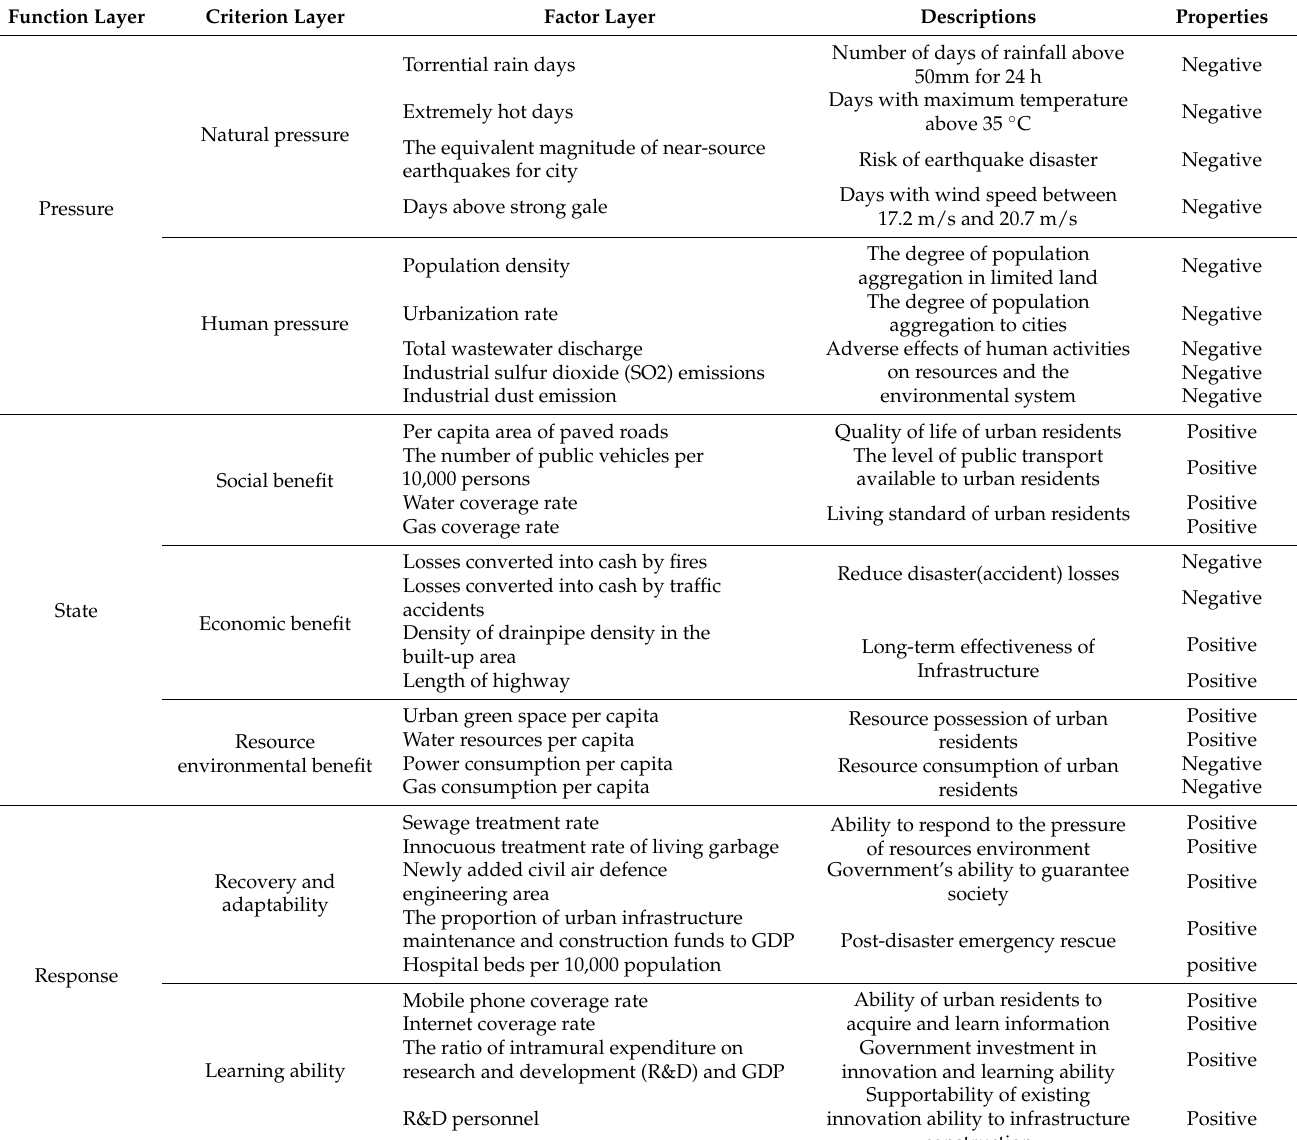
Table 2. The indicators system used in resilience assessment of urban Infrastructure on PSR